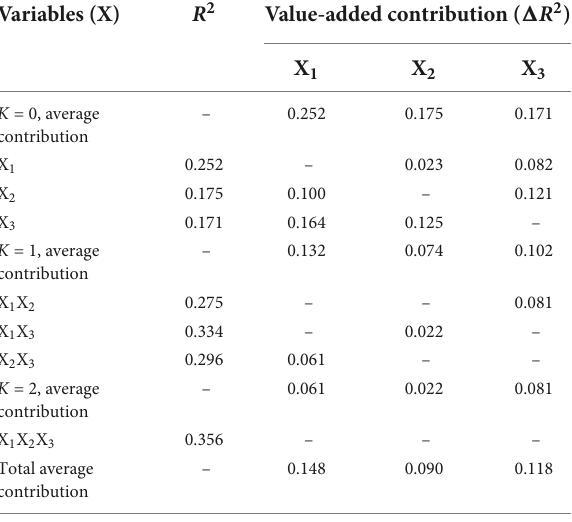
TABLE 3 When P = 3, the value-added contribution, average contribution and total average contribution of each predictor variable.